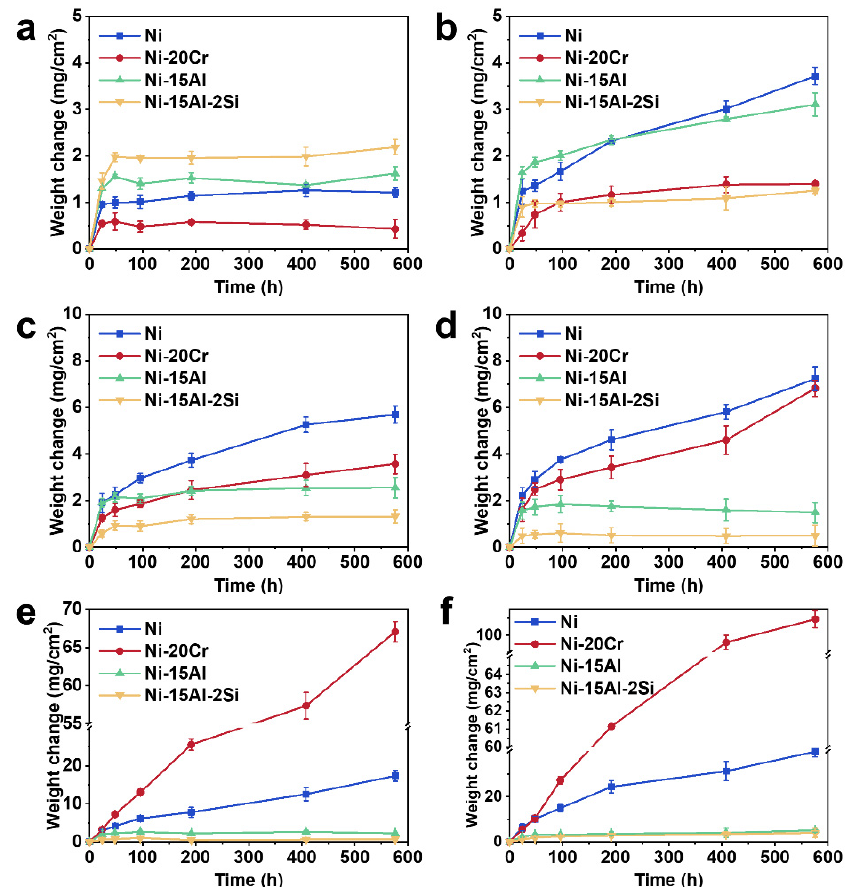
Figure 2. Oxidation kinetic curves of Ni, Ni-20Cr, Ni-15Al, and Ni-15Al-2Si alloys at ( a ) 700 °C, ( b ) 800 °C, ( c ) 900 °C, ( d ) 1000 °C, ( e ) 1100 °C, and ( f ) 1200 °C. Oxidation weight gains can directly reflect the oxidation performance of four samples.